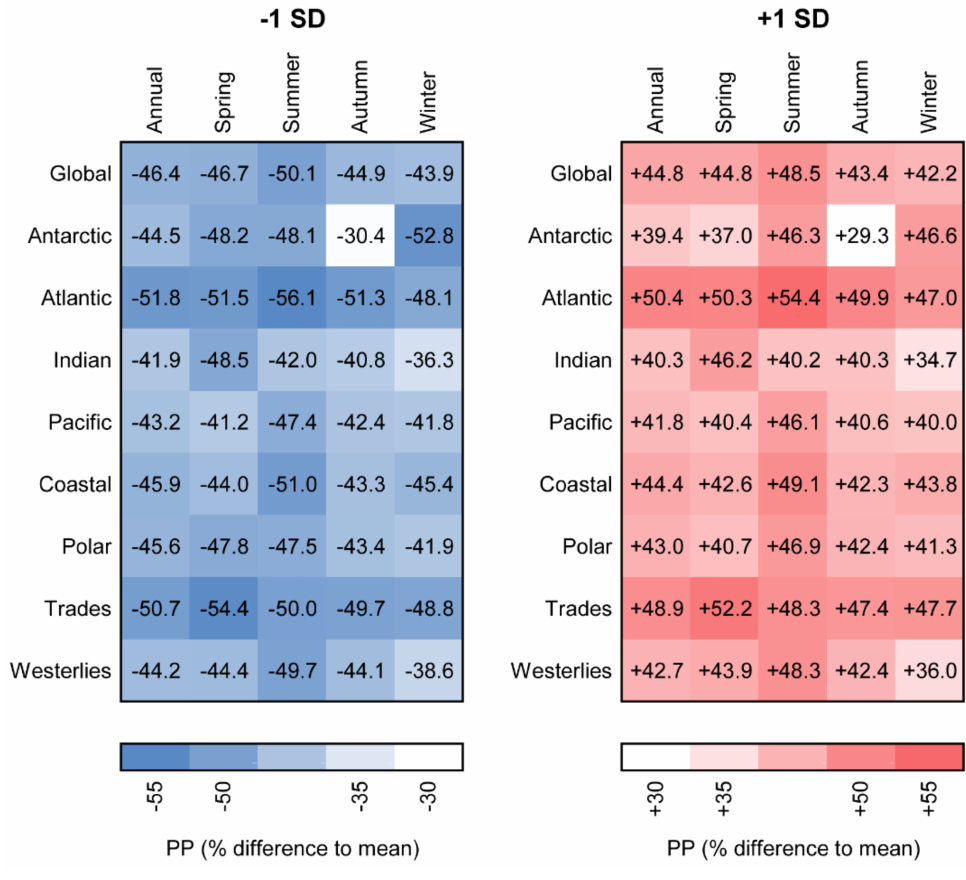
Figure 5. Percentage change in primary production (PP) for estimates based on mean photosynthesis versus irradiance (P-I) parameters ± 1 standard deviation compared with estimates based on mean P-I parameters. Mean percentage differences in annual and seasonal primary production for each ocean basin and biome are given. Data were obtained from model computations in which both P-I parameters were adjusted simultaneously and the light adaptation parameter (Ik) was